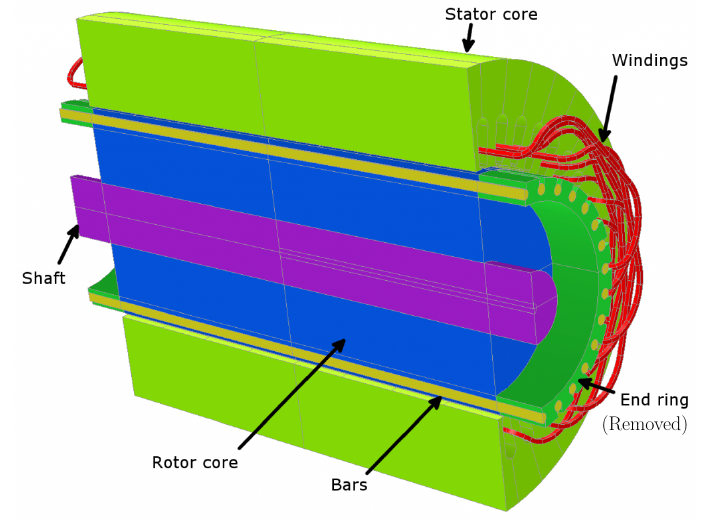
Figure 1. Stator windings and rotor bars of a three-phase squirrel cage induction